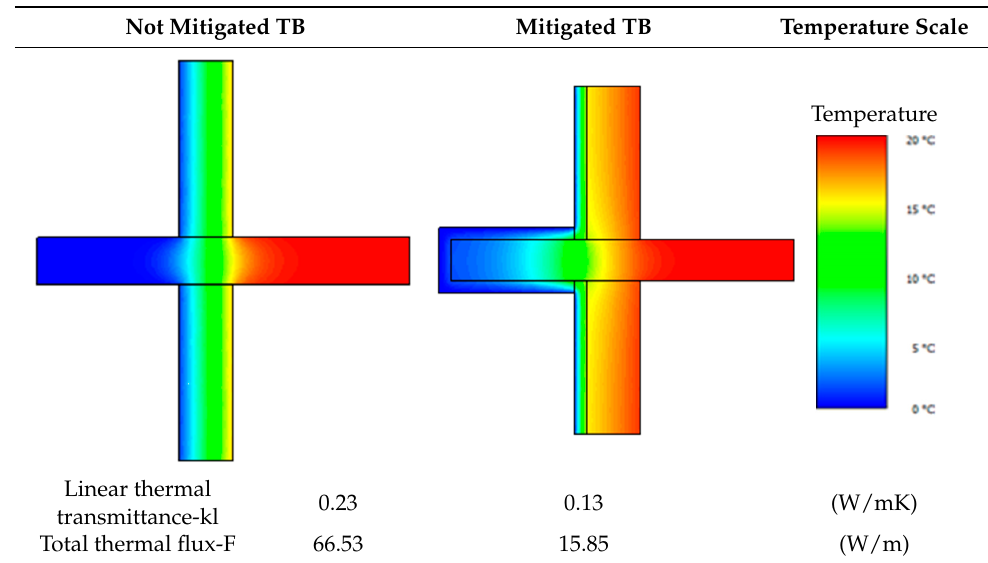
Table 9. B Thermal Table 9. B Thermal bridges. Table 9. B Thermal bridges. Table 9. B Thermal bridges.